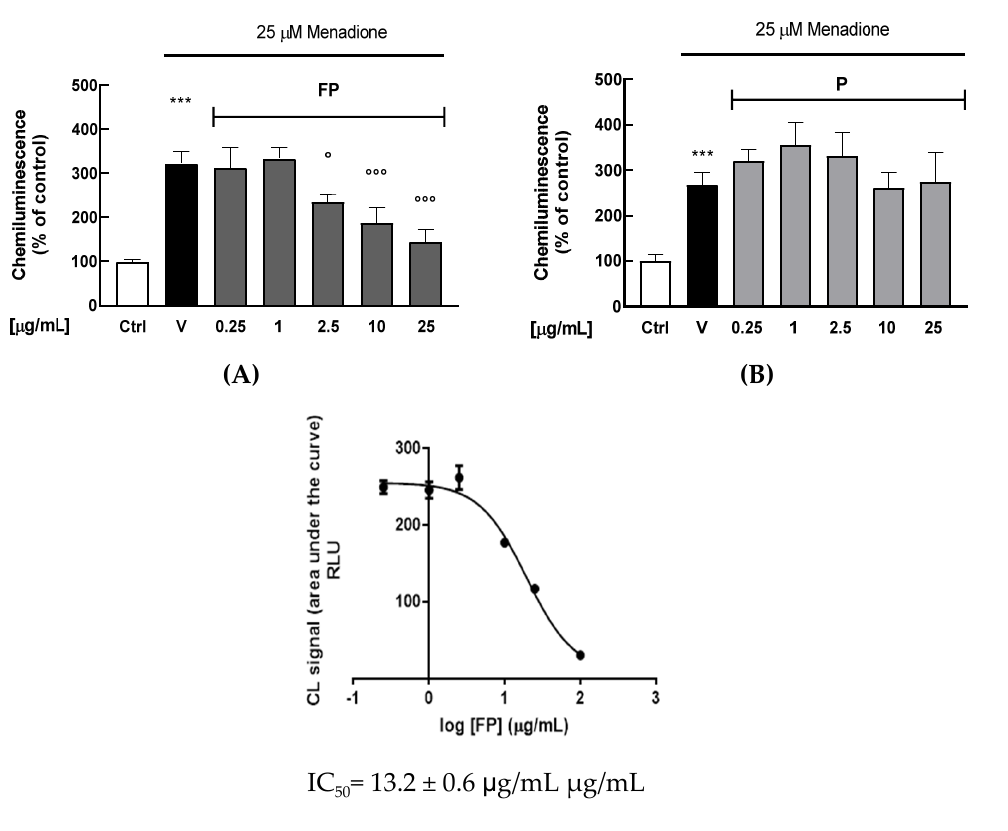
Figure 2. HUVECs were treated with fermented Pushgay (FP) ( A ) and Pushagay (P) ( B ) solutions for 24 h (concentrations range 0.25–25 µ g/mL) and then exposed to the pro-oxidant agent mena- dione (25 µ M for 40 min). Intracellular H 2 O 2 production was measured for 40 min through the CL effect-based bioassay. ( C ) Concentration-response plot of inhibition of intracellular H 2 O 2 produc- tion in HUVECs treated with FP (range 0.25–25 µ g/mL). Results are expressed as mean ± SD of three independent experiments. *** p < 0. 001 significantly different from the ctrl. ◦ p < 0.05 and ◦◦◦ p < 0.001 significantly different from V. Ctrl (control, untreated cells); V (control cells in presence of menadione); FP (cells treated with fermented Pushgay); P (cells treated with